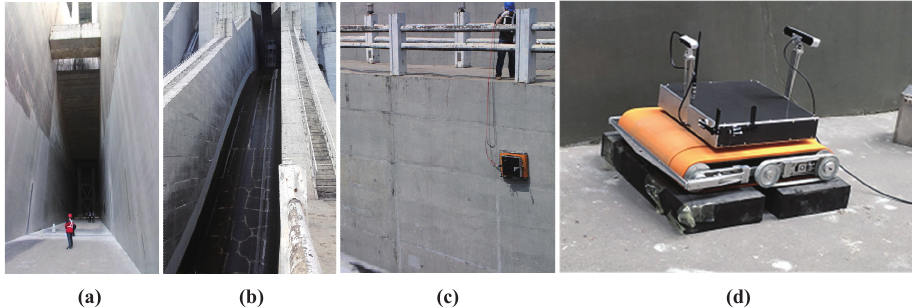
Figure 1. Field testing environment at Three Gorges Dam. ( a ) deep spillway, ( b ) drift spillway, ( c ) robot scanning on a vertical surface, ( d ) climbing robot.